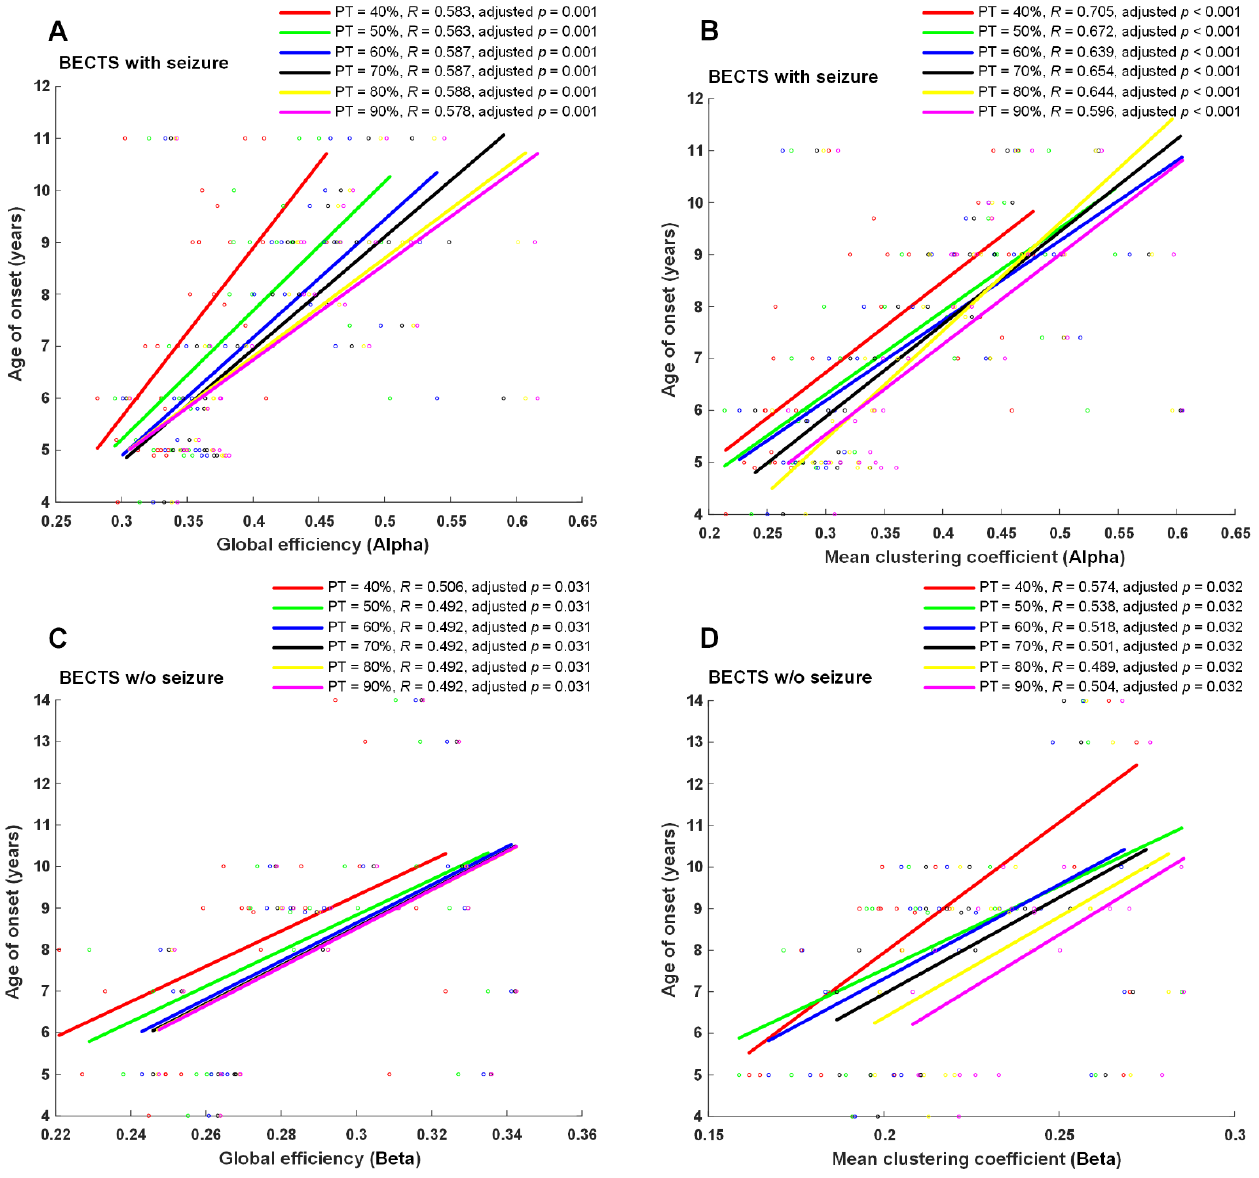
Figure 4. Scatter plots and correlation of graph ‐ theory ‐ based analysis vs. age of onset. Age of onset of seizures was significantly positively correlated with global efficiency and mean clustering coeffi ‐ cients in the alpha band (adjusted p ≤ 0.01 at ≥ 40% proportional threshold), shown in ( A , B ) in